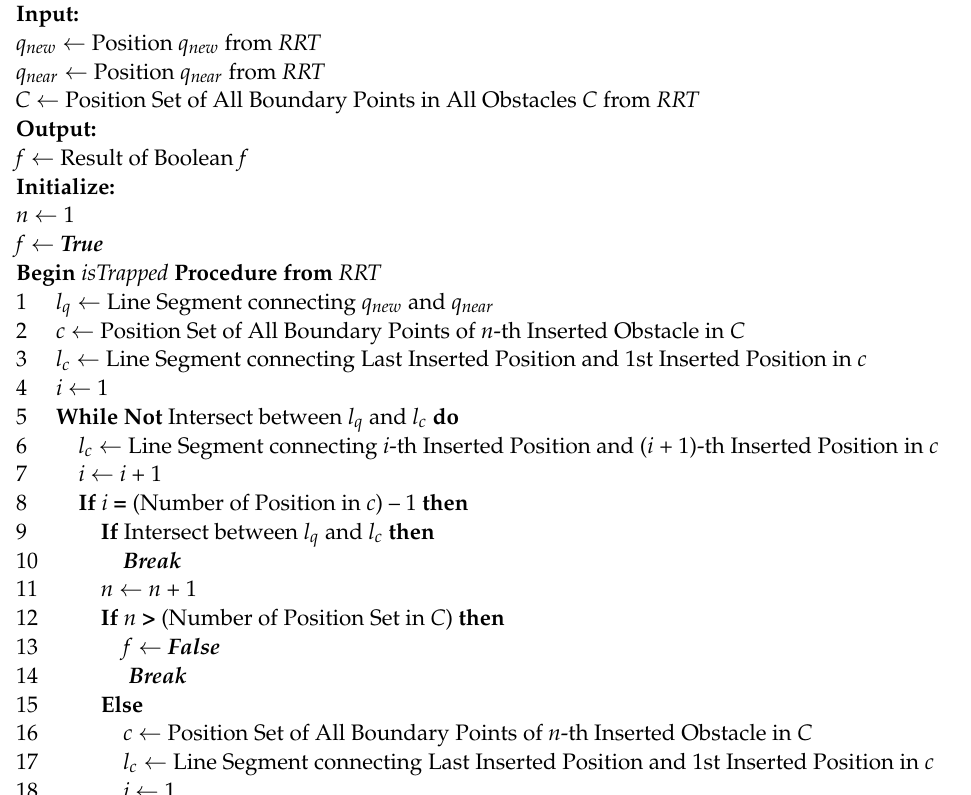
Algorithm A3 Pseudocode of the isTrapped Function from the RRT